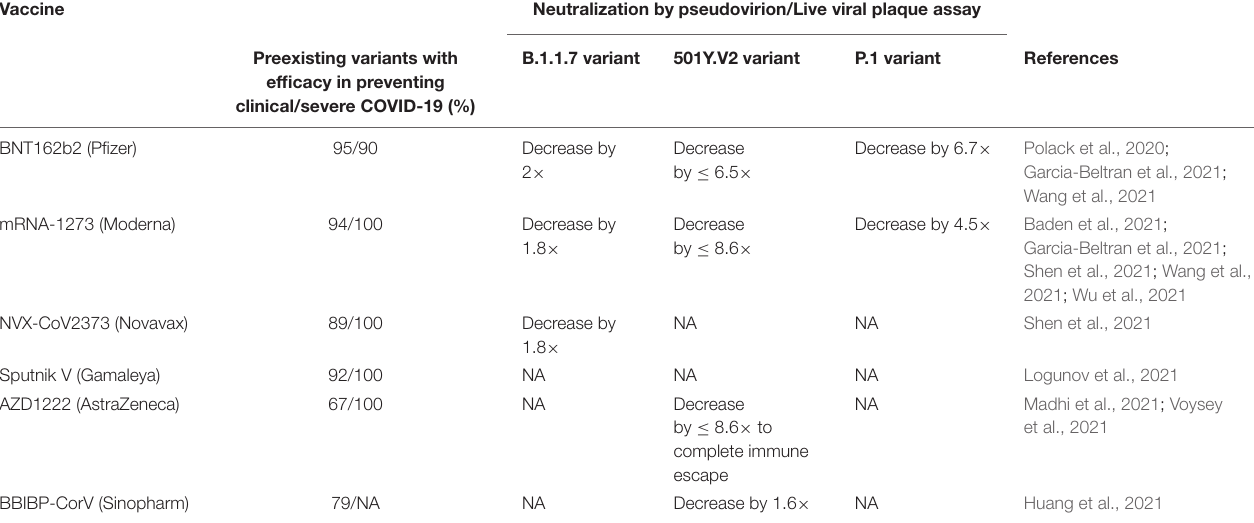
TABLE 4 | Description of SARS-CoV-2 vaccine trial efficacy and viral neutralization of B.1.1.7, 501Y.V2, and P.1 variants vs. preexisting variants (Abdool Karim and de Oliveira, 2021). Vaccine Neutralization by pseudovirion/Live viral plaque